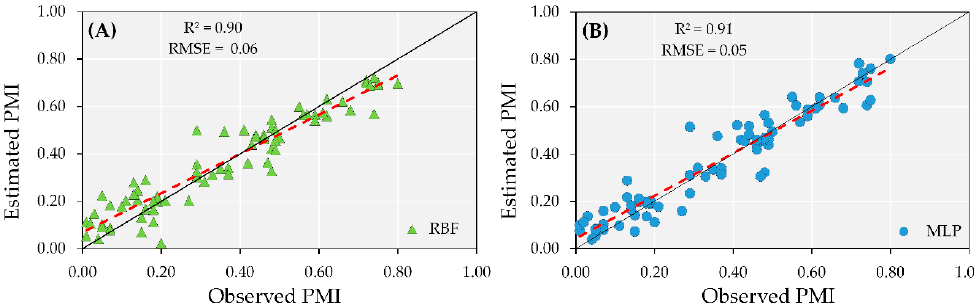
Figure 7. Test performance of artificial neural networks (ANN) models combining the dataset from irrigated and rainfed areas from both years using MLP ( A ) and RBF ( B ) to predict peanut maturity index (PMI).